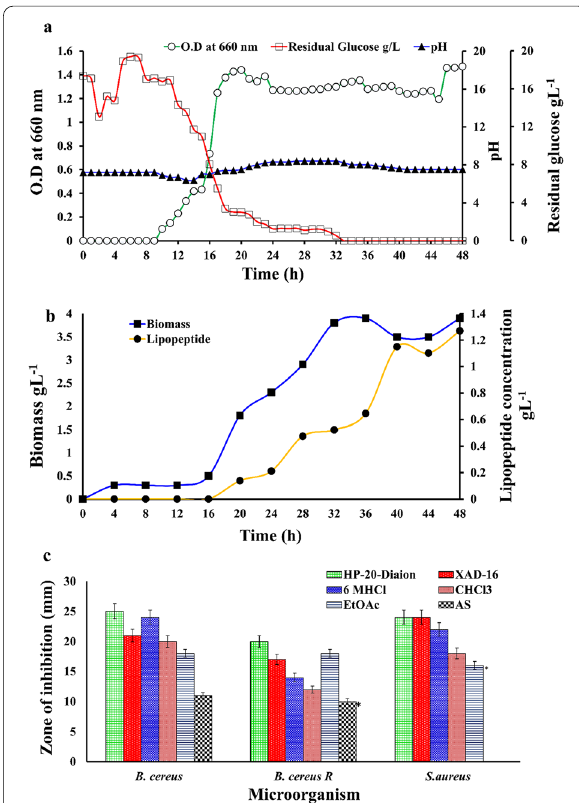
Fig. 2 a Time dependent growth curve analysis of B. velezensis SK, for growth (O.D at 660 nm), residual glucose concentration and pH. b Lipopeptides production and biomass production kinetics in MBM at 37 °C, 120 rpm agitation for 48 h. c Comparative antimicrobial activity of lipopeptides extracted by various methods from B.velezensis SK for efficient extraction against Gram-positive